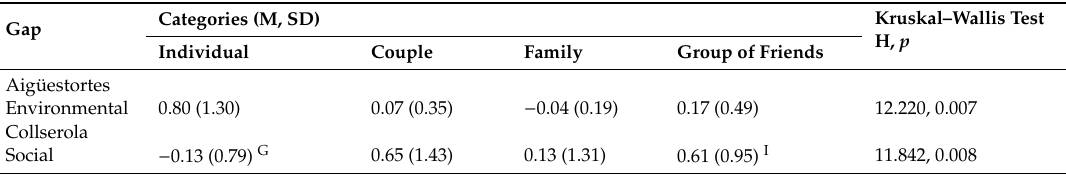
Table A2. Post hoc comparisons for the GAPs between expected benefits and satisfaction according to group composition.